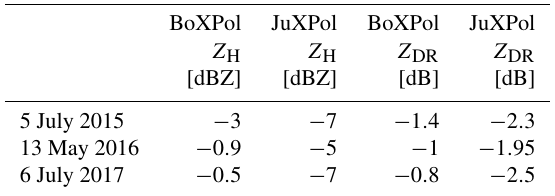
Table B1. Estimated biases for Z H and Z DR for both radars and for each